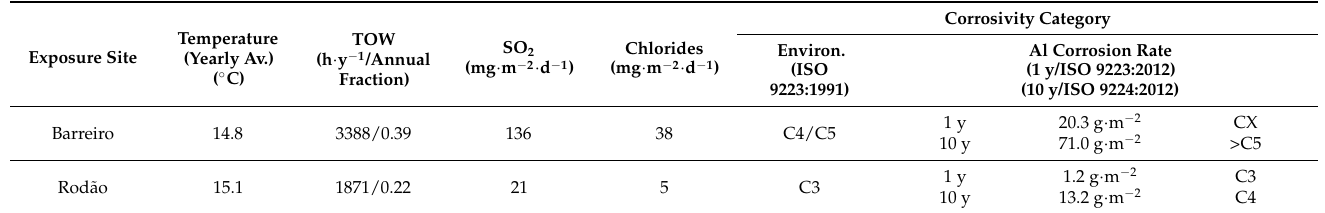
Table 1. Pollution levels, climatological characteristics and corrosivity categories of the exposure sites based on environmental data and on aluminum corrosion rates